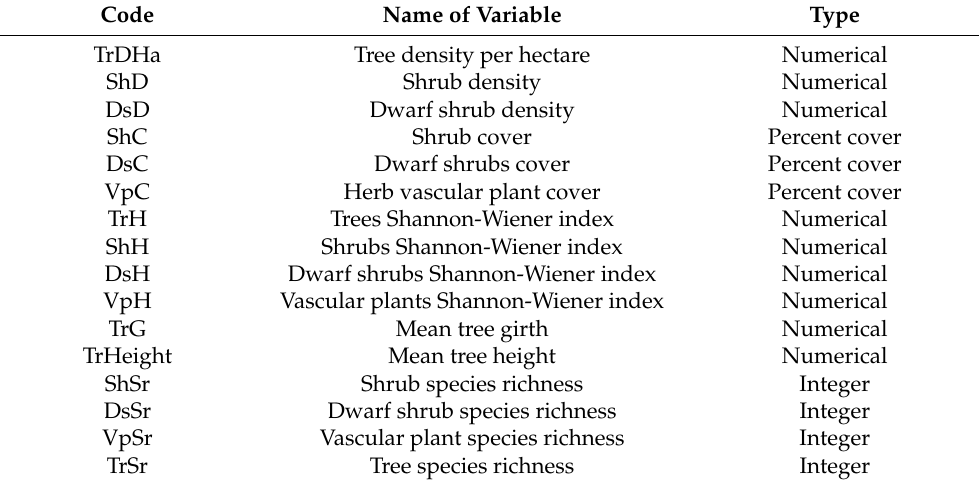
Table 1. The list of studied parameters—response variables of the influence of the edge. Code Name of Variable Type TrDHa Tree density per hectare Numerical ShD Shrub density Numerical DsD Dwarf shrub density Numerical ShC Shrub cover Percent cover DsC Dwarf shrubs cover Percent cover VpC Herb vascular plant cover Percent cover TrH Trees Shannon-Wiener index Numerical ShH Shrubs Shannon-Wiener index Numerical DsH Dwarf shrubs Shannon-Wiener index Numerical VpH Vascular plants Shannon-Wiener index Numerical TrG Mean tree girth Numerical TrHeight Mean tree height Numerical ShSr Shrub species richness Integer DsSr Dwarf shrub species richness Integer VpSr Vascular plant species richness Integer TrSr Tree species richness